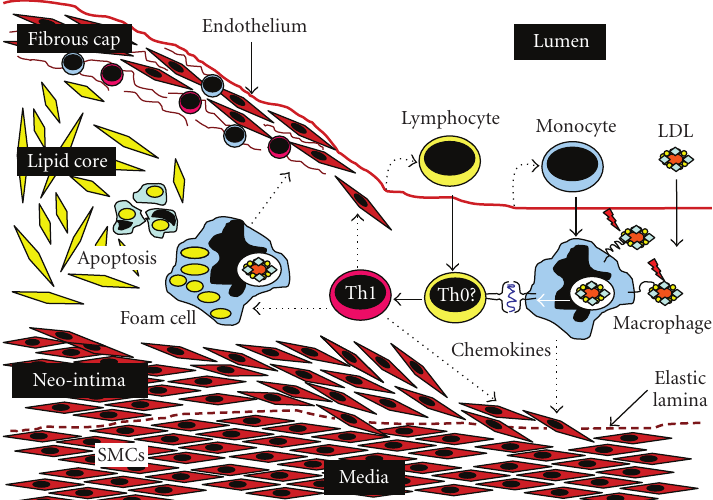
Figure 1: Inflammatory basis of atherosclerotic plaque formation. Led by inflammatory signals derived from the damaged endothelium, monocytes and lymphocytes migrate into the vessel wall. Monocytes di ff erentiate into macrophages that recognise and phagocytiose oxidised LDL particles. The protein component of the LDL particle is processed and presented in the form of peptides by macrophages (also by dendritic cells) to T-lymphocytes in the context of the major histocompatibility complex class II (MHC-II). Other self or foreign antigens that may gain access to the vascular wall can also trigger similar mechanisms. It is believed that most of these lymphocytes di ff erentiate in situ, under the influence of the specific antigen stimulation, into e ff ector T-cells, but this has yet to be demonstrated. Upon activation, both macrophages and lymphocytes release a range of proinflammatory molecules including chemokines which stimulate the migration of smooth muscle cells (SMCs) from the media. SMCs contribute to foam cell and fibrous cap formation. This process is facilitated by cytokines such as IFN γ and TNF α secreted by proatherogenic Th1 cells and also IL-12 secreted by macrophages and foam cells. Eventually foam cells die by apoptosis in situ leaving nondegradable cholesterol crystals that form the lipid core of the